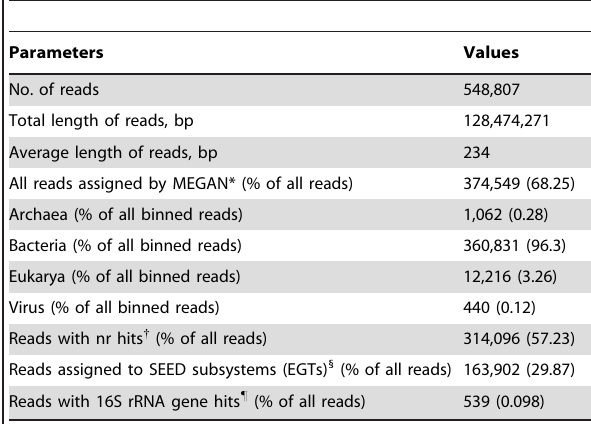
Table 1. Summary of pyrosequencing data from the fungus- cultivating termite whole gut